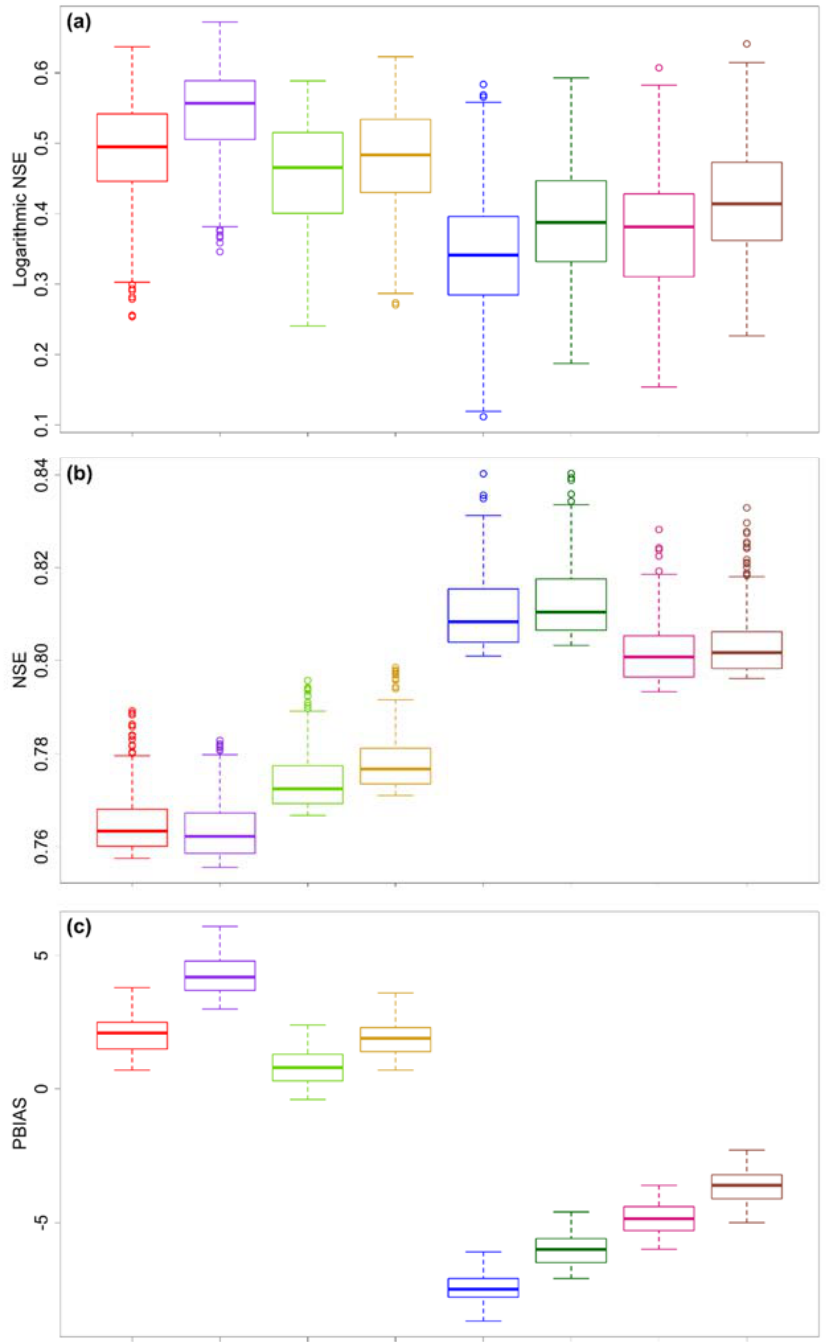
Figure 3. Posterior SWAT performance results after Bayesian calibration with the Markov Chain Monte Carlo (MCMC) algorithm, evaluated for different goodness-of-fit functions. The top panel ( a ) shows the posterior log Nash–Sutcliffe Efficiency (NSE) results in fitting the discharge observation, the middle panel ( b ) shows the NSE and the bottom panel ( c ) shows the percent bias (PBIAS). The X -axis shows the model setups.